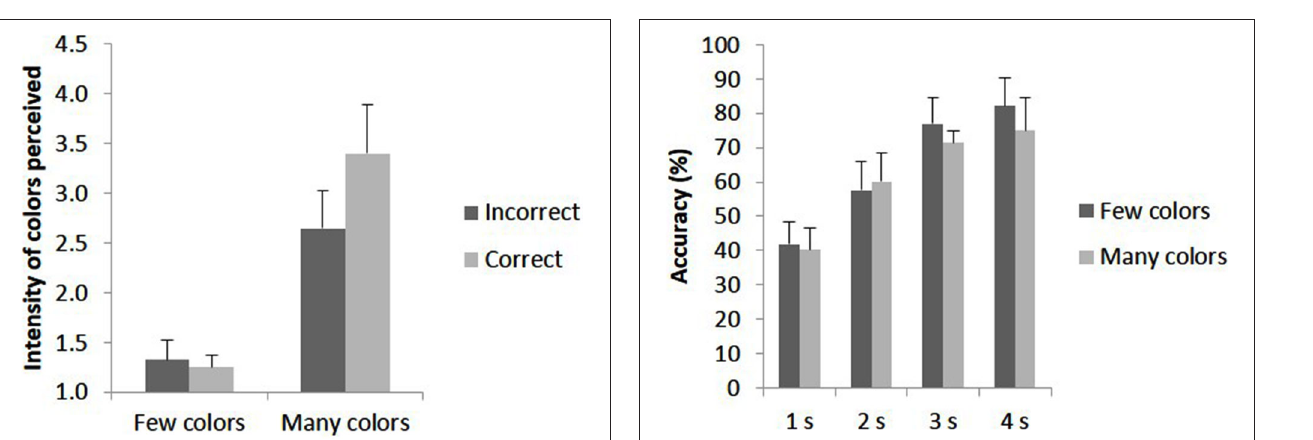
FIGURE 6 | Shape detection accuracy for lots and little color responders during the hypnosis condition across stimulus durations (1–4 s) . Error bars represent 1